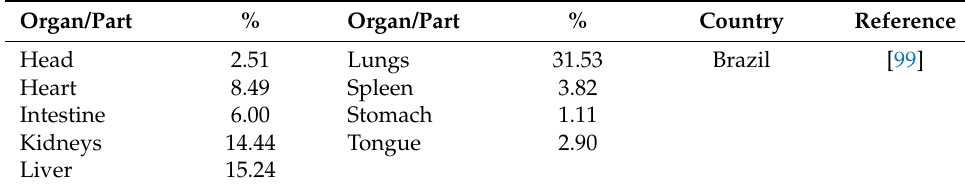
Table 7. Organ/partial condemnations in